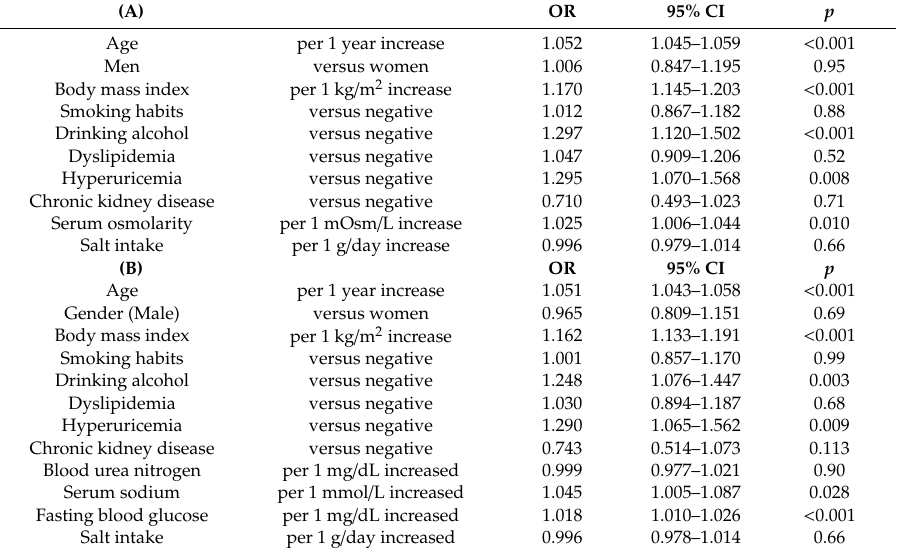
Table 3. Risk factors for hypertension over five years after multiple adjustments using serum osmolarity ( A ) and each element of serum osmolarity, namely, blood urea nitrogen, serum sodium, and fasting blood glucose ( B ).